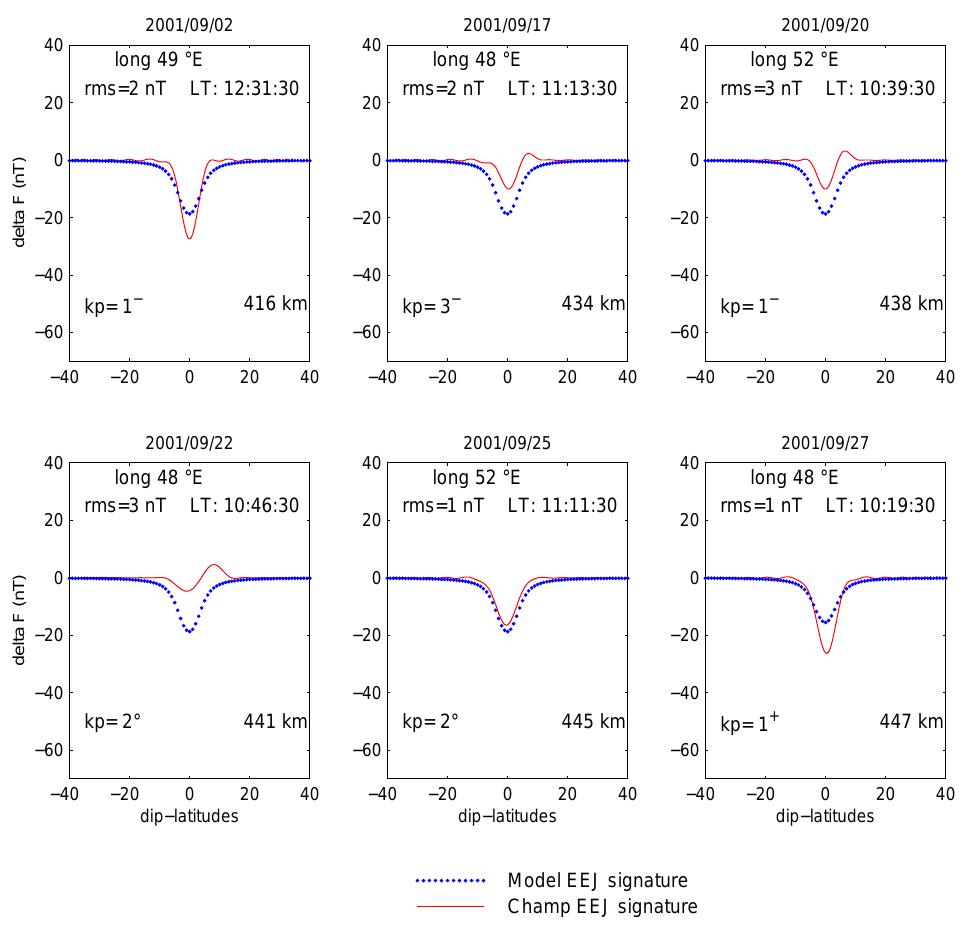
Fig. 7b. Comparison between the CHAMP satellite magnetic signature and the modeled magnetic effects of the EEJ. The modeled EEJ magnetic effects extrapolated at the altitude, longitude and local time of CHAMP satellite passes (blue dotted line) are compared with the observed EEJ signatures (red solid line) in the longitude band 15 ◦ W to 30 ◦ W. The modeled profiles were computed using the mean longitudinal profile of the EEJ magnetic signature. The altitude, longitude, local time and the rms are